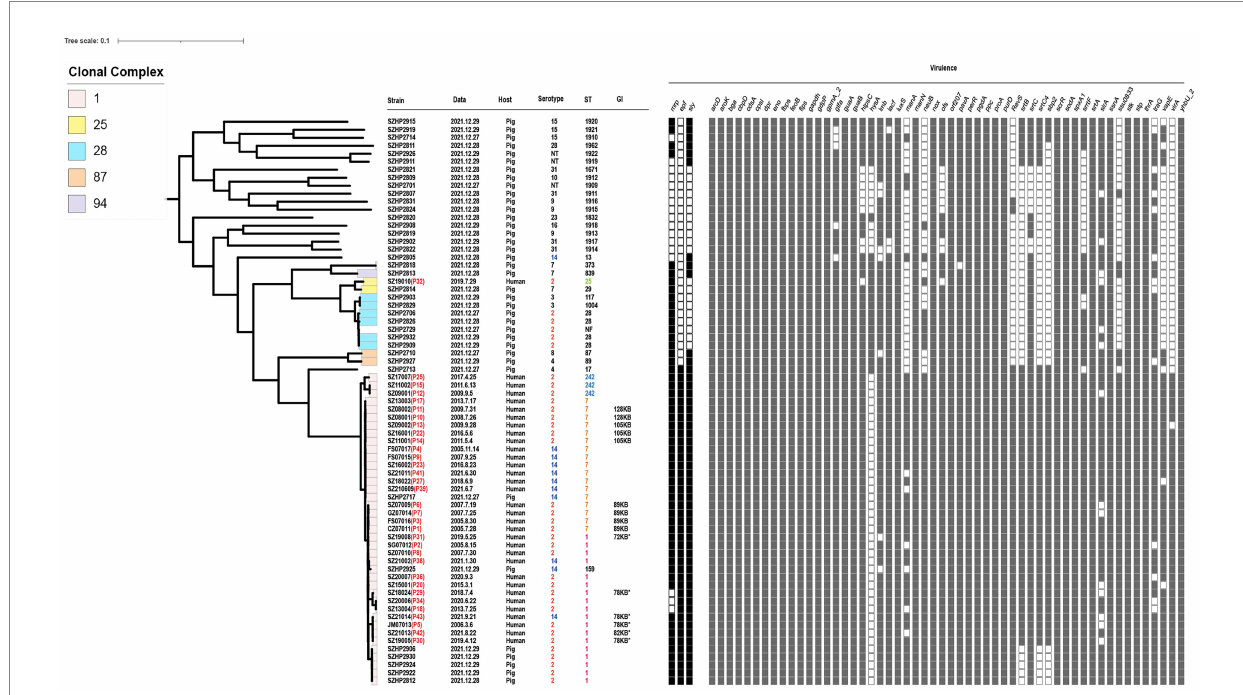
FIGURE 1 Information and virulence genes of 71 Streptococcus suis isolates in Shenzhen. The red font after the strain number is the patient number. Data mean the onset time of human isolates and the isolation time of swine isolates. Serotype, ST, clone complex, and host of 71 isolates are described. “*” indicates that it is derived from 89 KB PAI. Squares are filled with color when the corresponding virulence gene is